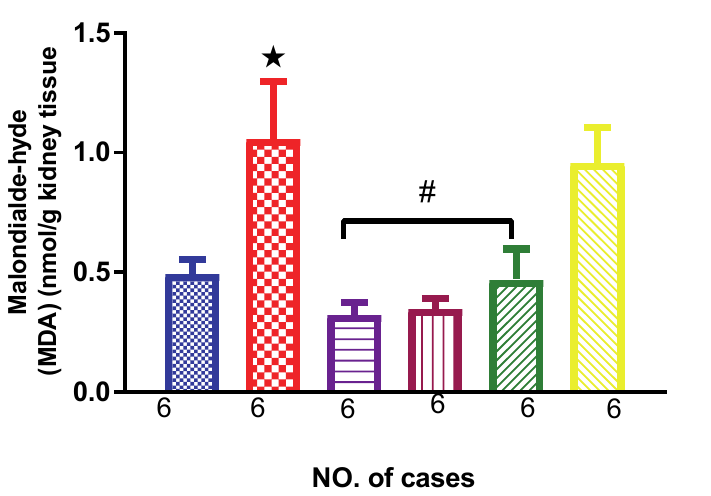
Figure 3. MDA concentration in normal control (NC), prediabetic control (PD), metformin and diet intervention (MET + DI), metformin and high-fat/high-carbohydrate diet (MET + HFHC), rhenium (V) compound and diet intervention (Re + DI), and rhenium (V) compound and high-fat/high-carbohydrate diet (Re + HFHC) groups after 12 weeks of treatment. Values are presented as means ± SEM (n = 6). (cid:70) p < 0.05 in comparison with NC; # p < 0.05 in comparison with PD, MET +DI, MET + HFHC, Re + DI and Re + HFHC.